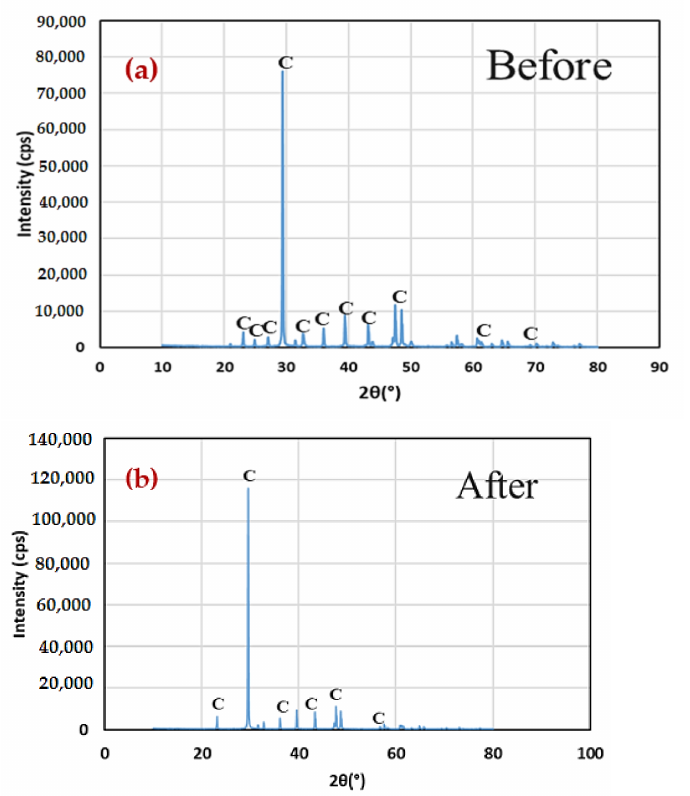
Figure 12. XRD results of the treated specimens exposed to WD cycles. ( a ) Before ( b )